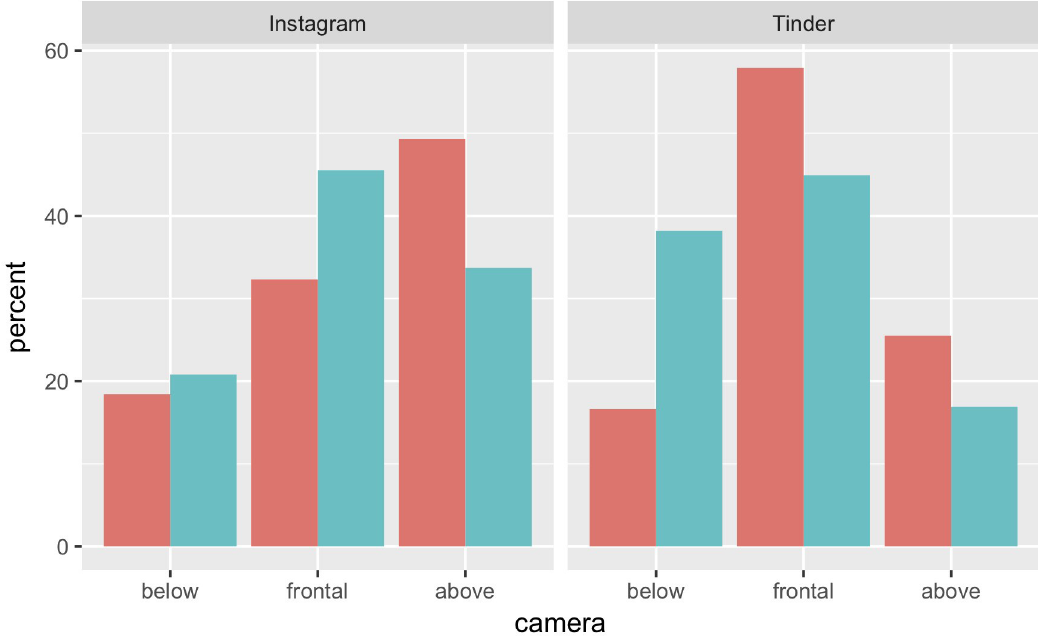
Fig 1. Percentages of male (pale blue) vs female (pinkish red) selfies by vertical camera angle, on Instagram (current study, left) and on Tinder ([28], right).